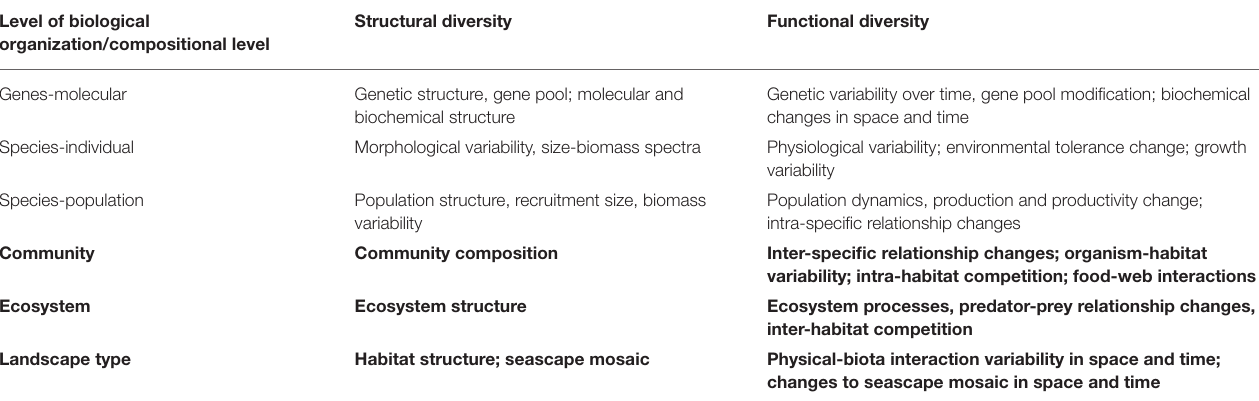
TABLE 1 | Structural and functional biodiversity examples across levels of biological organization (topics focused on in the current paper in bold) (extensively modified from Zacharius and Roff, 2000).